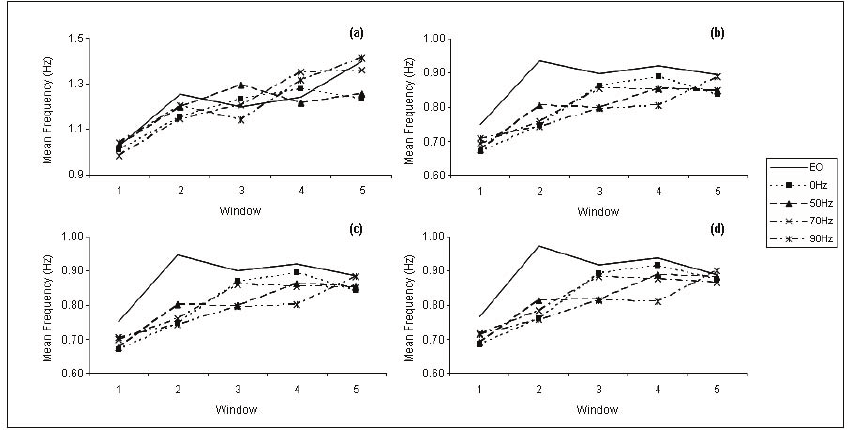
Figure 6. The effect of time on mean frequency estimation using Fourier–Bessel Expan- sion for 200-point windows (ML): (a) No window; (b) Hamming window, (c) Gaussian window ( (cid:5) D 2:5 ), (d) Kaiser window ( ˇ D 8